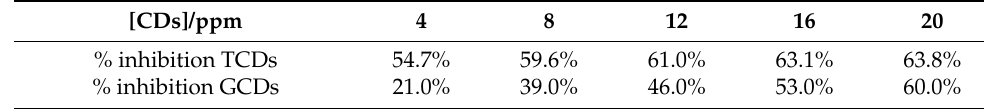
Table 1. DPPH% inhibition at different concentrations of CDs.